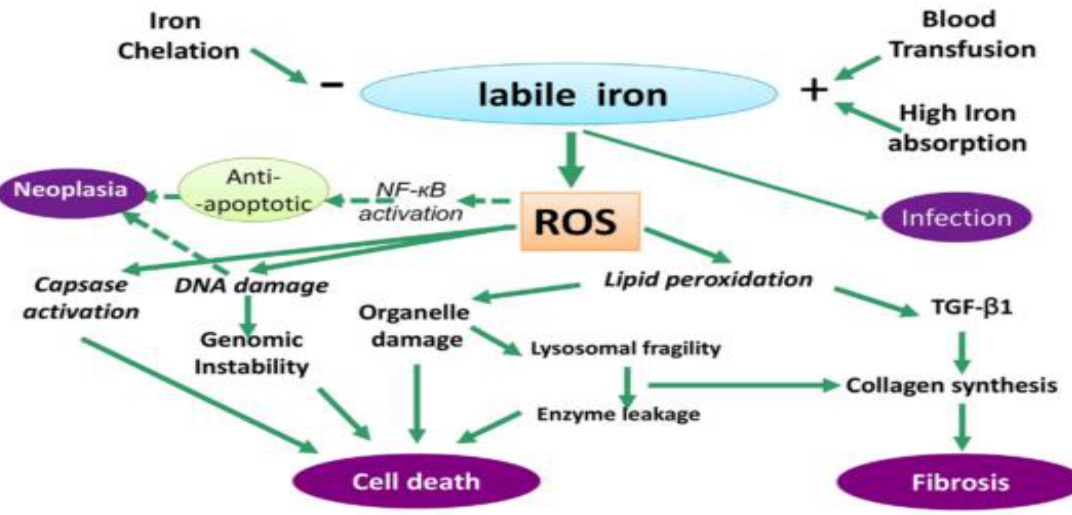
Figure 1. Pathologic mechanisms and consequences of iron overload (10)